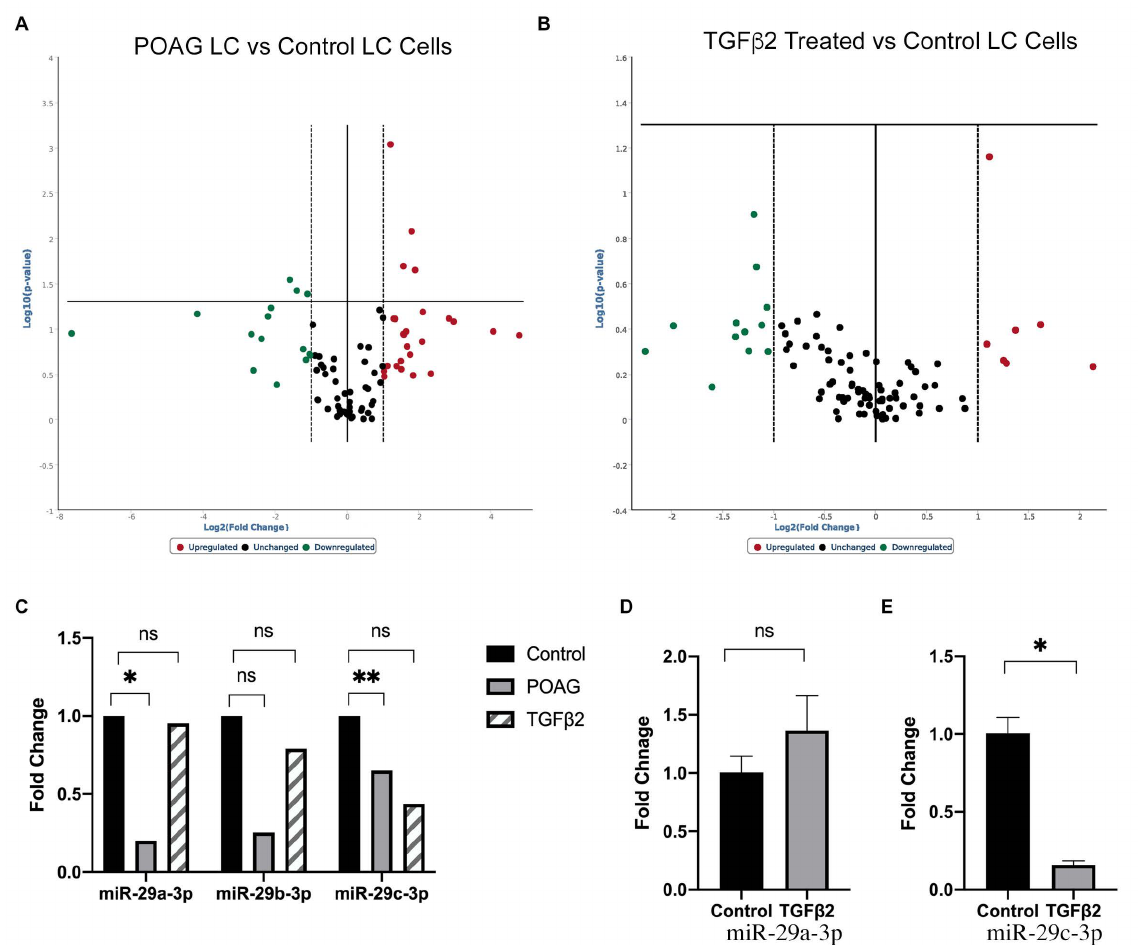
Figure 1. Analysis of differentially expressed mature miRNA in LC cells. Volcano plots of fibrosis pathway-related miRNAs in ( A ) normal and glaucoma primary human LC cells, or ( B ) normal human LC cells treated with or without TGF β 2 for 24 h. Upregulated miRNAs are shown in red to the right, and downregulated miRNAs are shown in green to the left. The horizontal bar indicates the threshold significance of p < 0.05. miRNAs were considered significantly upregulated/downregulated if they passed the threshold significance of p < 0.05 (horizontal line). ( C ) Expression of the miR-29 family in glaucomatous and TGF β 2 treated LC cells compared to controls. Evaluation of ( D ) miR-29a-3p or ( E ) miR-29c-3p expression in TGF β 2 treated LC cells analyzed by qPCR ( p < 0.05), n = 3 biological replicates. * p < 0.05; ** p <